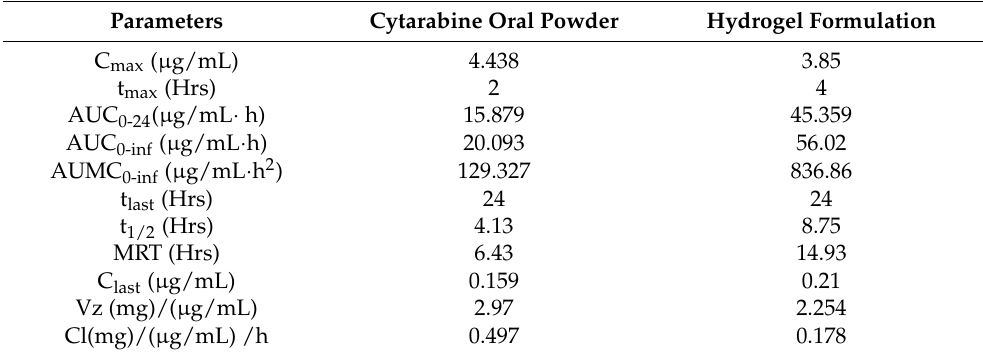
Table 5. Pharmacokinetic parameters of pure Cytarabine powder solution and Cytarabine loaded hydrogel after oral administration .